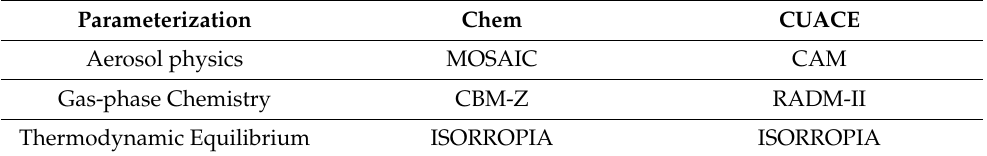
Table 2. Chemical processes of WRF/Chem and